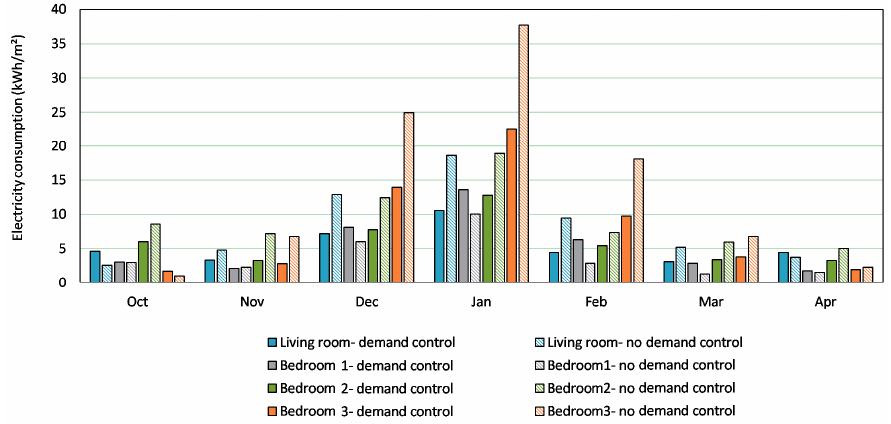
Figure 30. The electricity consumption of each room with/without demand control in winter.